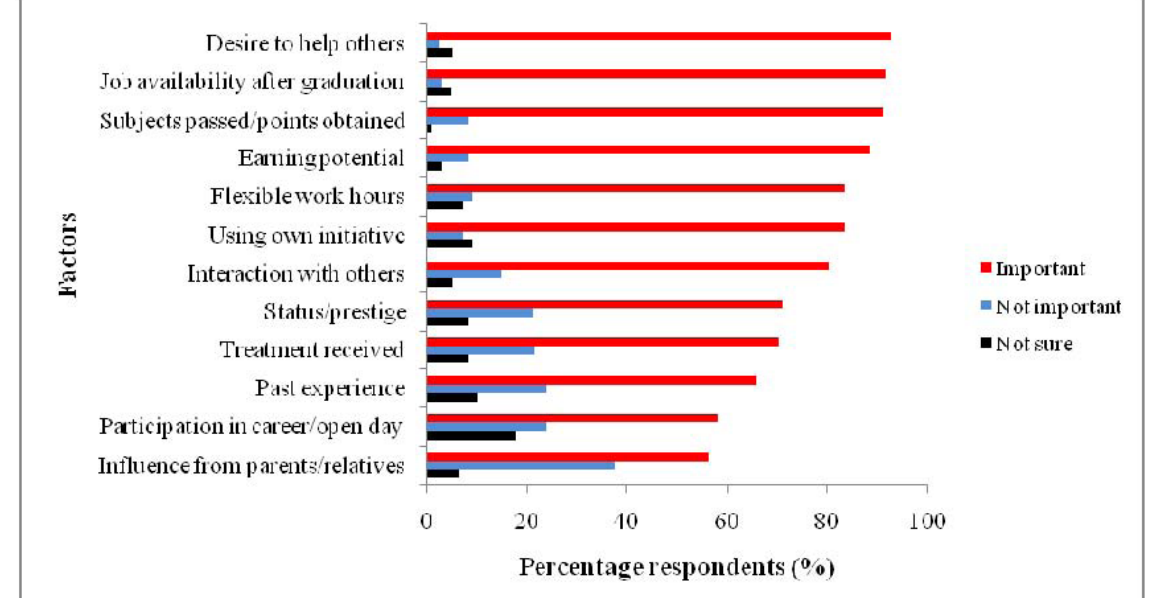
Figure 1: The ranking of importance of factors which influenced the decision of the respondents to pursue optometry as a career. Most of the students (90% and above) rated the desire to help others, job availability and subjects passed and points earned as im- portant factors for deciding on optometry as a